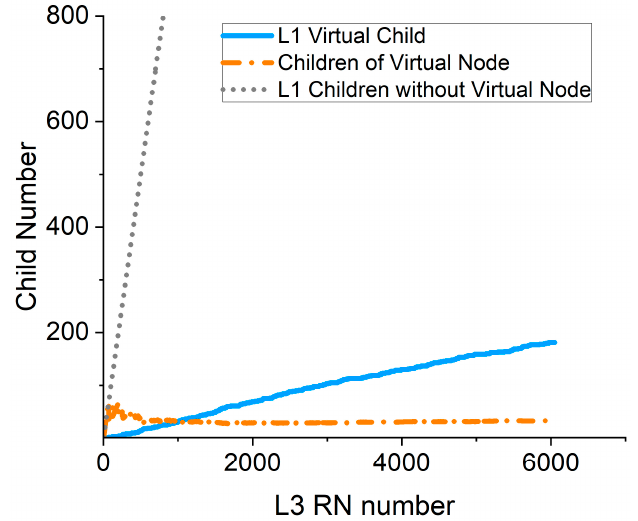
Figure 13. Maintenance overhead with and without virtual node design.